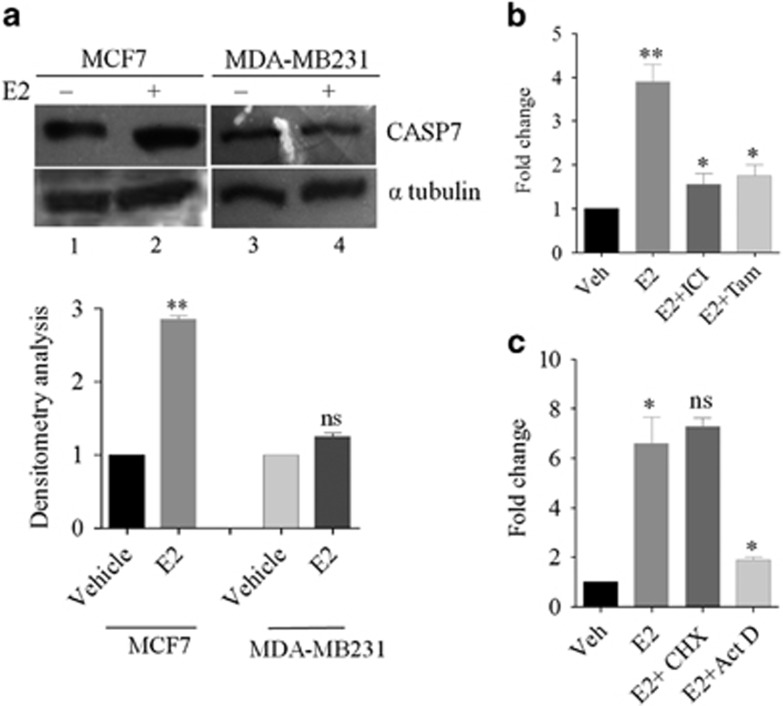
Estrogen regulates CASP7 expression. (a) Western blot showing CASP7 expression in MCF7 and MDA-MB231 cell line under E2 influence (upper panel) and densitometry (lower panel). (b) Quantitative RT–PCR showing CASP7 mRNA expression after treatment with E2 and E2 inhibitors- ICI182,780 and tamoxifen. (c) Quantitative RT–PCR showing CASP7 mRNA expression with protein synthesis and transcription inhibitors, cyclohexamide and actinomycin D, respectively. **P<0.01. *P<0.05. ns=no significant change.